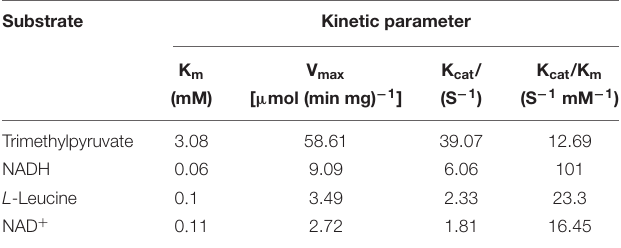
TABLE 1 | The kinetic parameter of Pf LeuDH. TABLE 3 | Substrate specificity of Pf LeuDH in reductive amination and oxidative